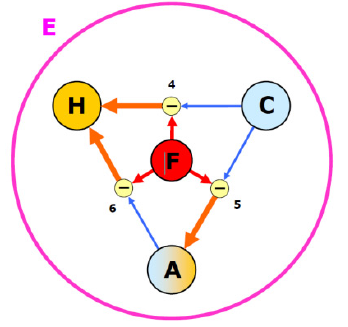
Fig. 8. – Negative thermodynamic cycles —sorption